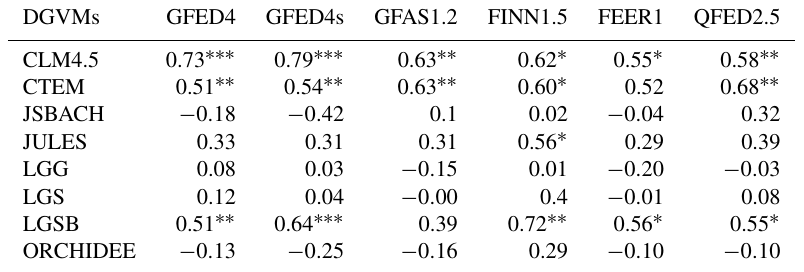
Table 7. Temporal correlation of annual global fire PM 2 . 5 emissions between FireMIP models and satellite-based GFED4 and GFED4s